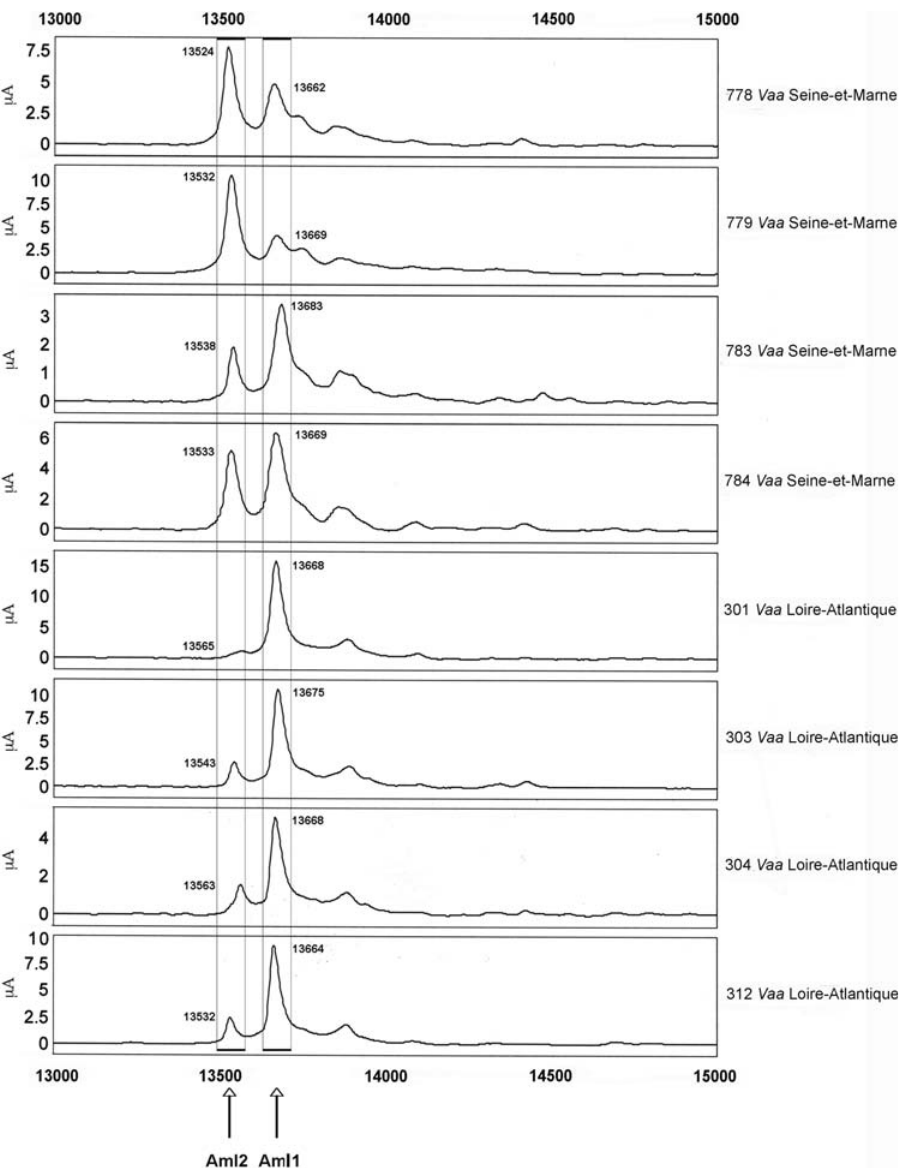
Figure 7. SELDI profiles of venoms from Seine-et-Marne (code no. 77) and Loire-Atlantique (code no. 44). Peaks matching the molecular weights of AmI1 and AmI2 are indicated on the spectra.